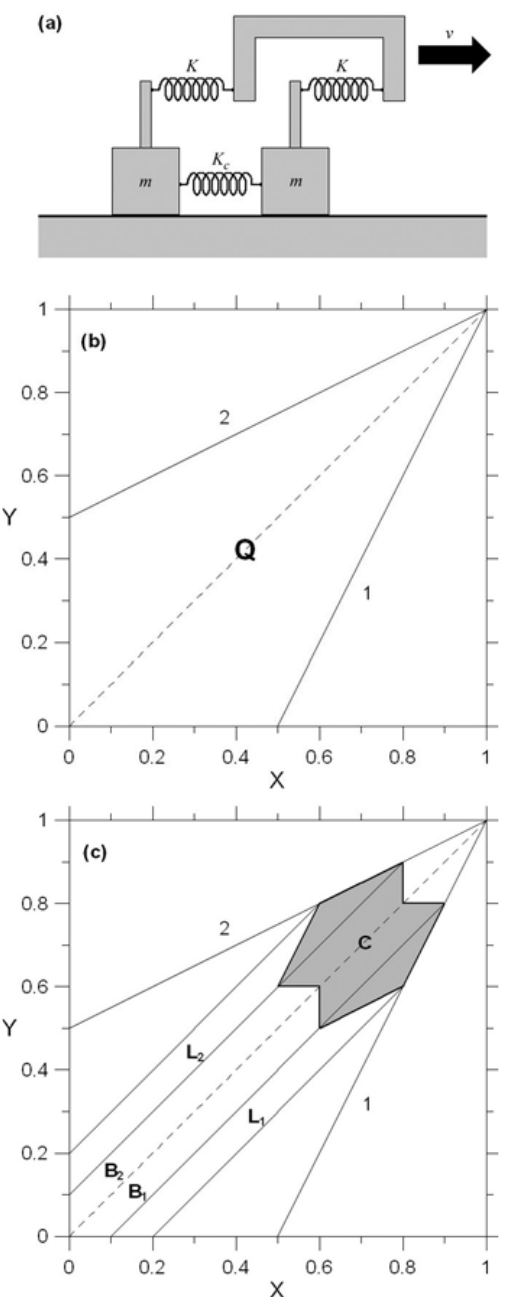
Fig. 1. (a) The two-block system; (b) projection of the phase space in the plane XY and the quadrilateral Q ( α = 1); (c) noteworthy subsets of Q : B 1 , B 2 , L 1 , L 2 , and the set C of limit cycles ( (cid:15) = 0 . 7).